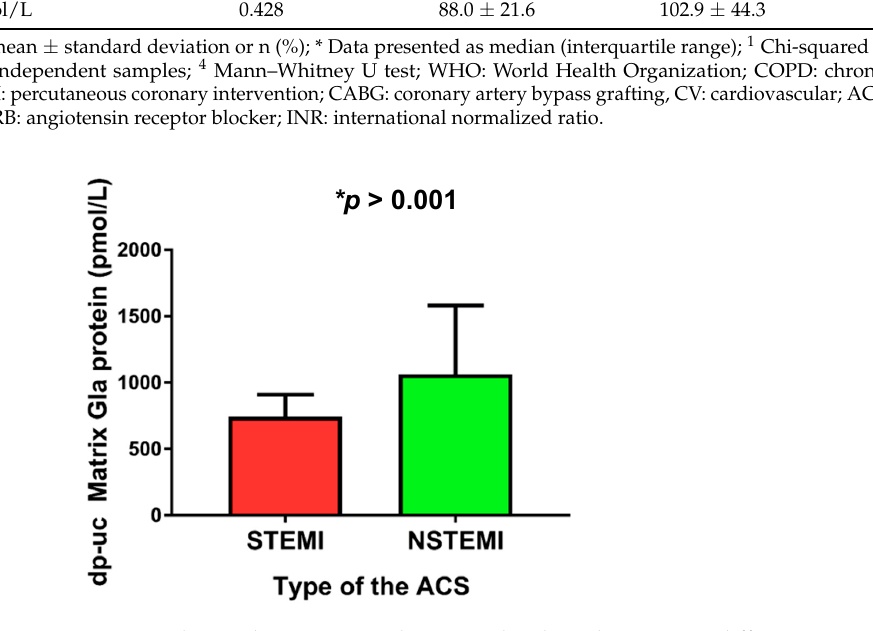
Figure 1. Plasma dp-uc matrix Gla protein levels with respect to different types of ACS (STEMI vs. NSTEMI). Abbreviations: dp-ucMGP: dephosphorylated and uncarboxylated matrix Gla protein; STEMI: ST-elevation myocardial infarction; NSTEMI: non-ST elevation myocardial infarction; ACS: acute coronary